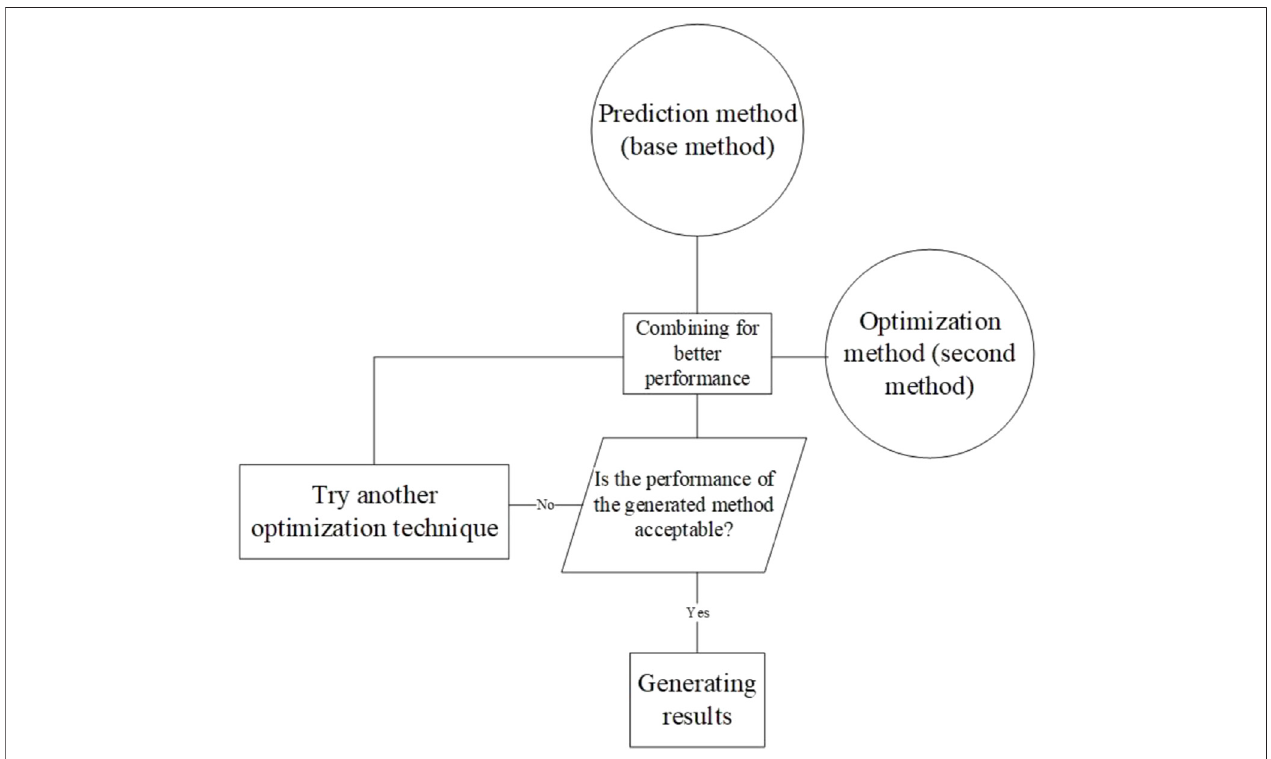
FIGURE 5 | Simple algorithm of developing a hybrid technique.